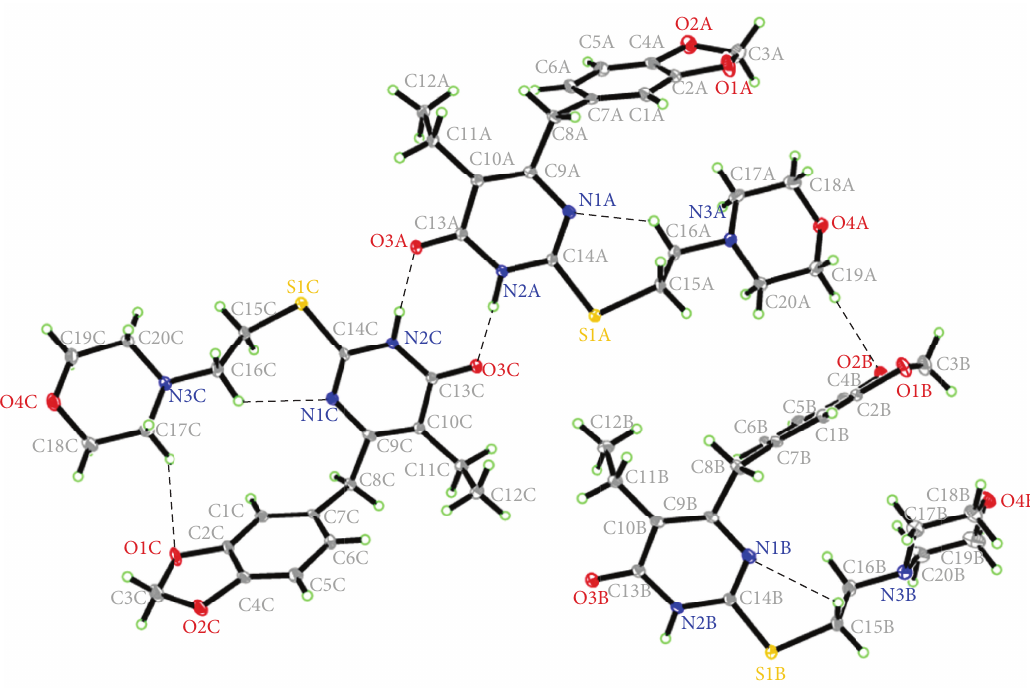
Figure 1: ORTEP diagram of the title compound 8 drawn at 50% ellipsoids for non hydrogen atoms.